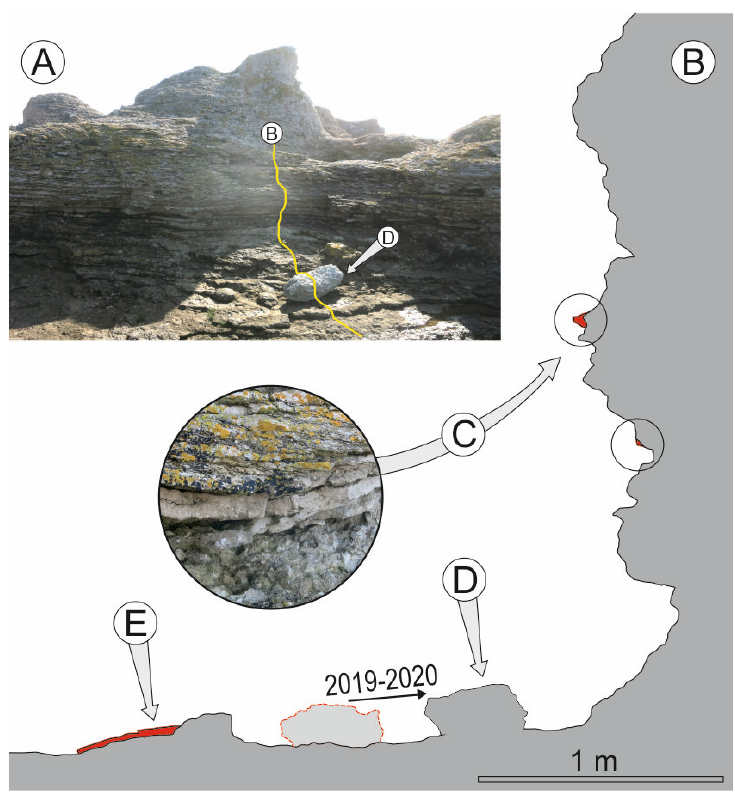
Figure 7. Examples of erosion within laminated limestones at the Gamla Hamn site: ( A ) a piece of rauk built from laminated limestone; ( B ) rauk profile based on a TLS point cloud with marked points of erosion from 2019 and 2020 (marked in red); ( C ) a piece of limestone layer recently eroded and dislodged, identified based on the TLS differential analysis; ( D ) a displaced boulder at the rauk’s foot; ( E ) erosion on limestone slabs.